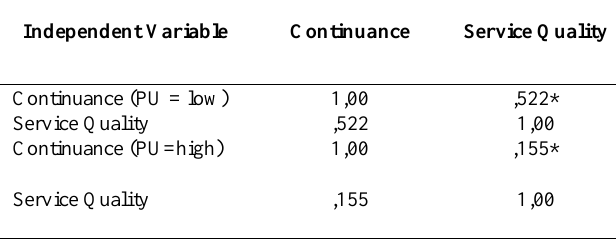
Table 6: Sub group matrix showing the relationship between continuance intentions and service quality with low and high levels of perceived usefulness